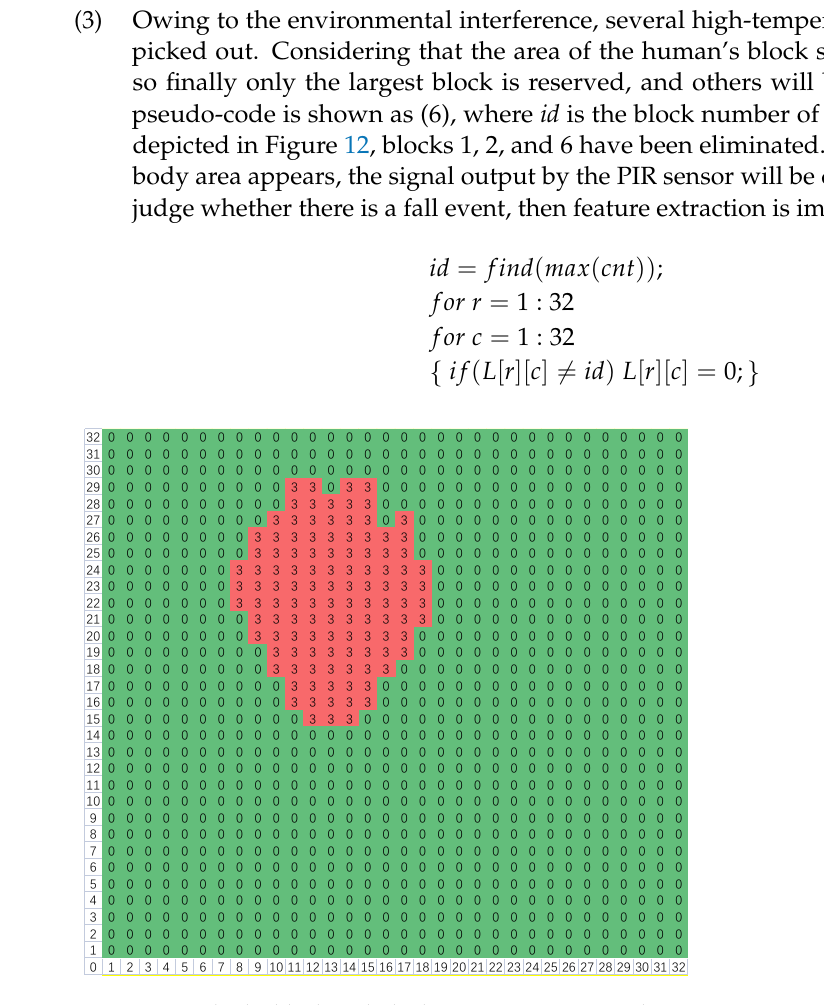
Figure 12. Only the block with the largest area is reserved.